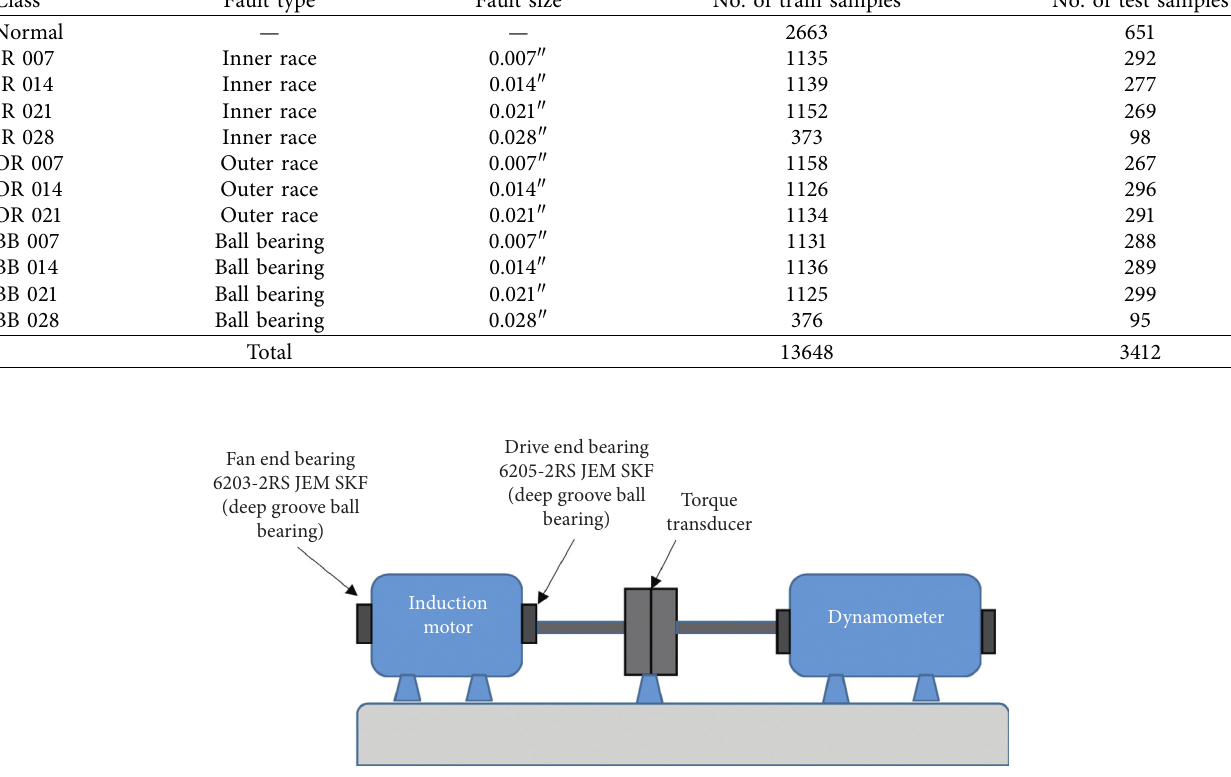
Figure 2: CWRU test rig schematic diagram.